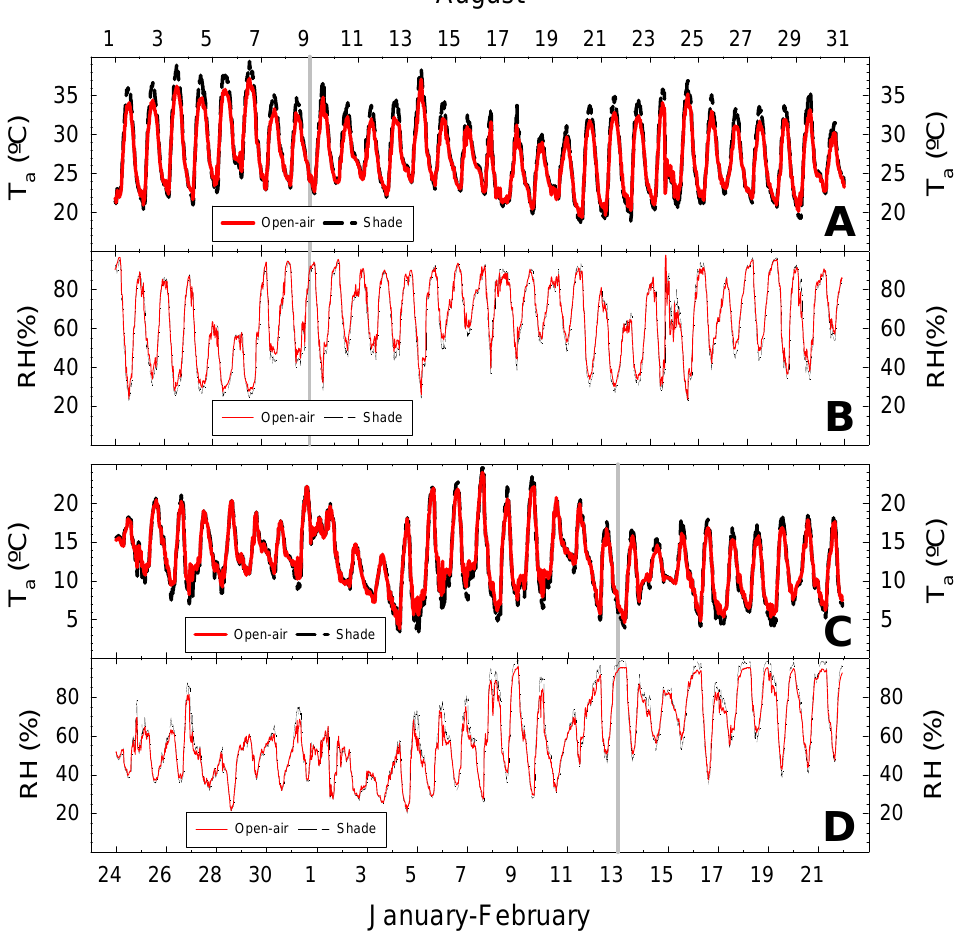
Figure 1. Diurnal pattern of air temperature (T a ) and relative humidity (RH) during representative months of summer (August 2018; A , B ) and winter (January-February 2019; C , D ) in open-air (solid line) and under shade netting (dashed line). Vertical grey lines indicate days of measurements (August 9 th 2018 and February 13 th 2019).